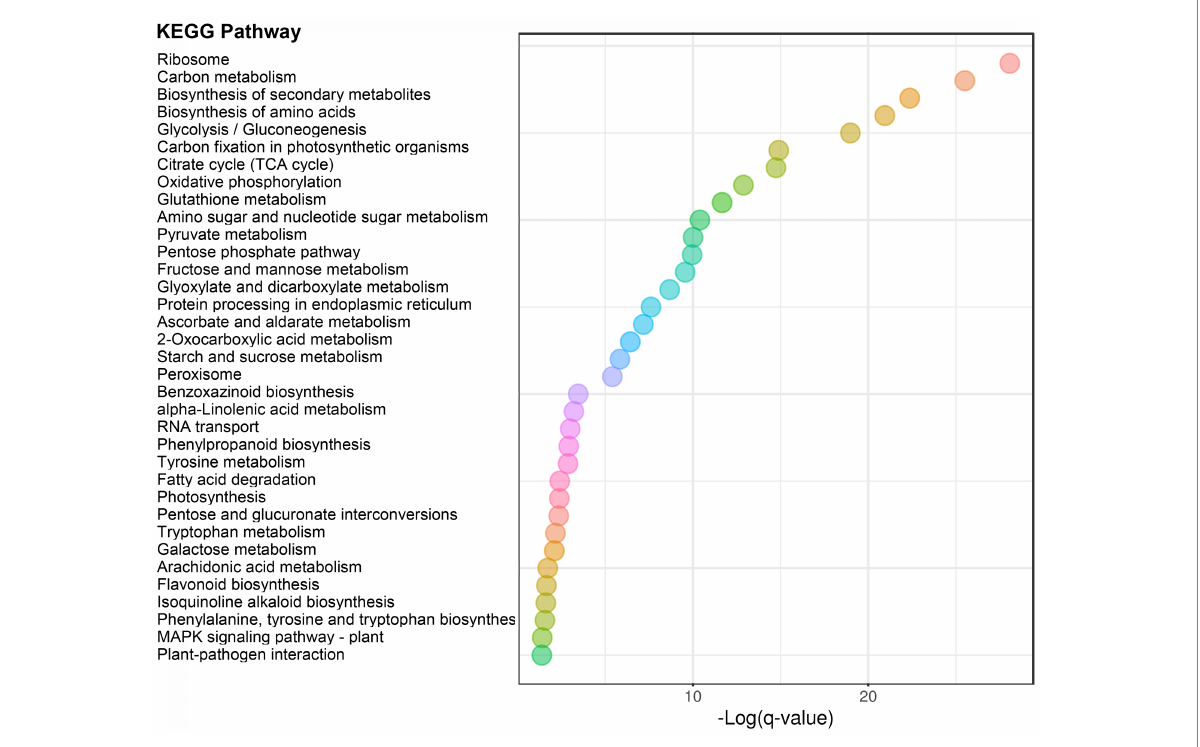
FIGURE 5 KEGG enrichment analysis of upregulated Khib-modified proteins between 0 and 2 dpi. The abscissa indicates the degree of significant